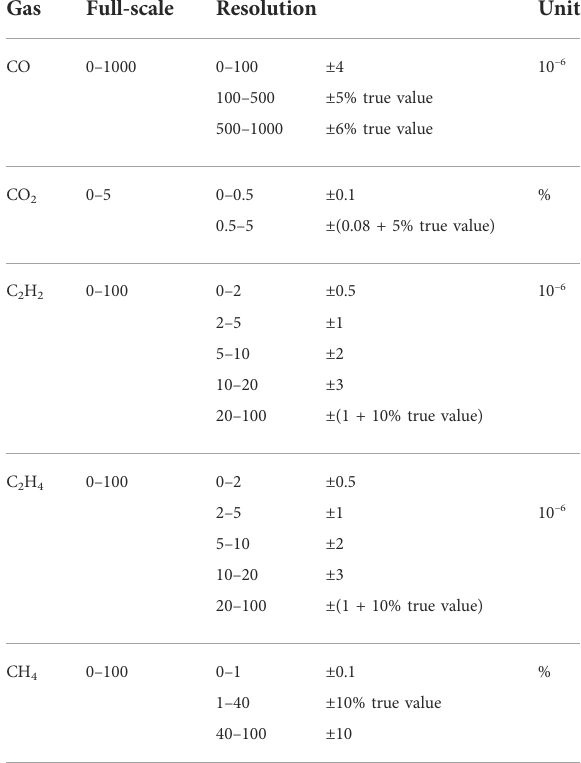
TABLE 1 Measurement requirements of multi-gas